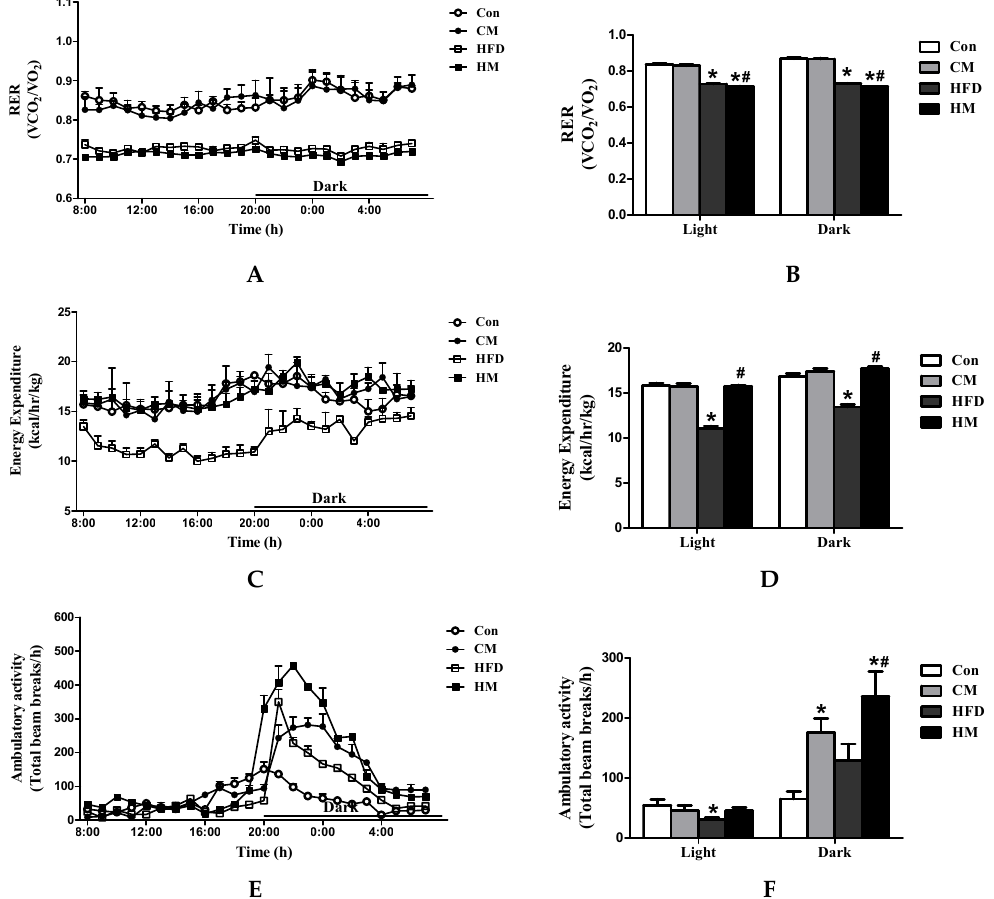
Figure 2. Myricetin increased energy expenditure and promoted the utilization of lipids as fuels. ( A , B ) RER; ( C , D ) energy expenditure; and ( E , F ) ambulatory activities of mice that were fed myricetin ‐ enriched diets for additional 12 weeks after 12 weeks of Con or HFD feeding. Bar graphs represent mean values during the light and dark cycles. Values were presented as mean ± SEM ( n = 8). Con, control diet; CM, control diet with additional 0.12% myricetin; HFD, high ‐ fat diet; HM, high ‐ fat diet with additional 0.12% myricetin. * p < 0.05 vs. the Con group; # p < 0.05 vs. the HFD group.